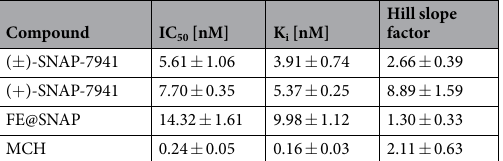
Table 1. Binding affinity of MCHR1 antagonists. Displacement of specific [ 125 I]MCH binding on CHO-K1 cell membranes expressing the hMCHR1. Data in the table are expressed as mean ± SEM from three independent experiments each performed in